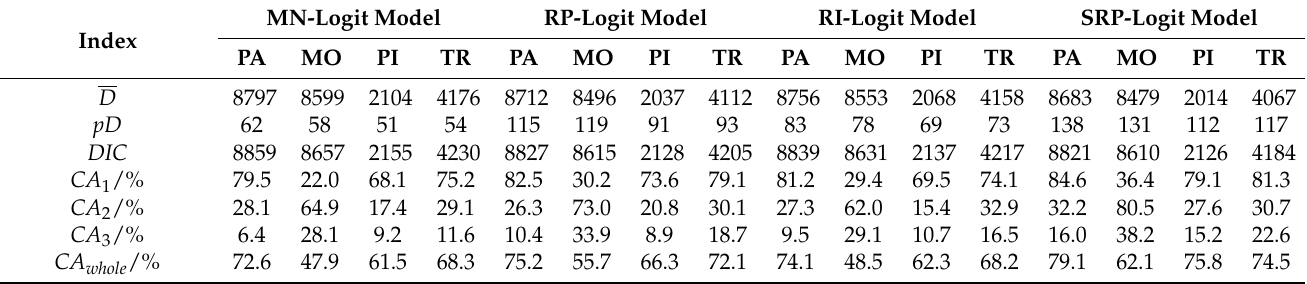
Table 3. Comparison results of model